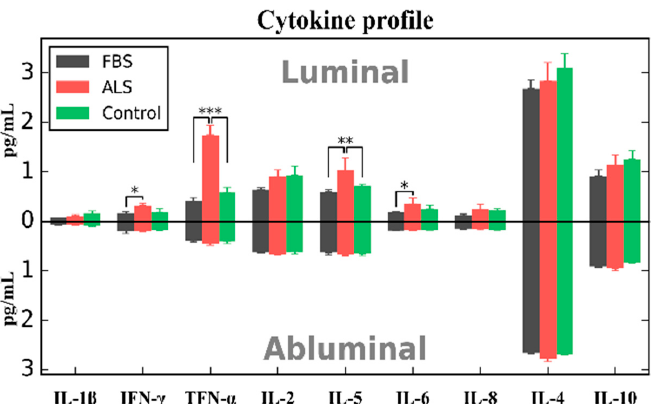
Figure 2. Cytokine profile of media collected from luminal ( upper ) and abluminal ( lower ) compartments. Media was collected from luminal (insert, upper) and abluminal (24-well plate, lower) compartments separated by a porous membrane at 5 DIV after exposure to FBS, plasma from ALS or control patient. At luminal side, significant increase of IFN- γ , TNF- α , IL-5, and IL-6 cytokine concentrations were determined at luminal compartment primarily after cell exposure to ALS plasma. There were no differences in cytokine levels between any cell culture conditions at abluminal side of construct. Data are presented as means ± S.E.M. * p < 0.05, ** p < 0.01, *** p < 0.001.